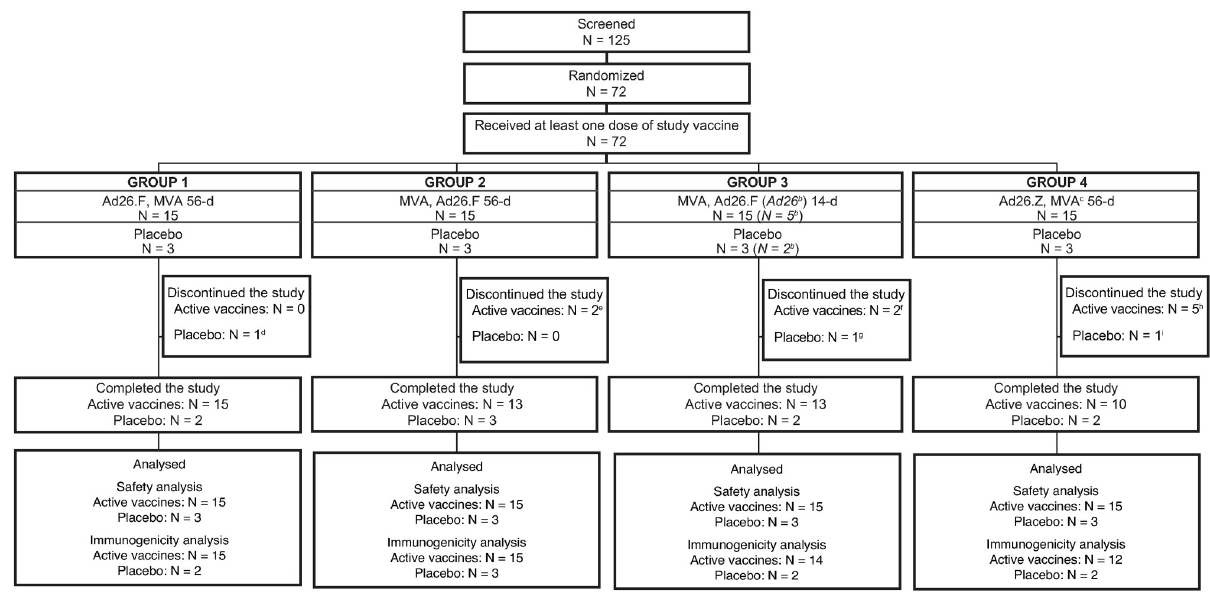
Fig 1. Participant disposition a . Ad26.F = Ad26.Filo; Ad26.Z = Ad26.ZEBOV; Inf U = infectious units; MVA = MVA-BN-Filo; N = number of participants. a A total of four participants had a major protocol deviation. In Group 1, one participant received disallowed concomitant therapy (bleomycin and cisplatin) during the post-dose 2 follow-up period. In Group 2, one participant did not have a Day 8 visit. In Group 4, one participant did not have a Day 8 visit, and another participant received a disallowed concomitant therapy (prednisone) and, as a result, discontinued the study prior to receiving the second vaccination. Participants were considered lost to follow-up after multiple unsuccessful contact attempts. b Only a subset of Group 3 participants received a booster vaccination. c MVA-BN-Filo at a dose of 1x10 8 Inf U. d Participant was unable to attend visits due to a family emergency. This participant had only received dose 1 vaccination. e Participants were lost to follow-up. One of two participants had only received dose 1 vaccination. f One participant was lost to follow-up and one participant suddenly relocated. One of two participants had only received dose 1 vaccination. g Withdrawal by the participant (no longer interested in participating). This participant had only received dose 1 vaccination. h Withdrawal by the participant (one participant was out of town and no longer interested in participating, one participant did not want to receive the second vaccination, one participant relocated, and one participant moved out of state) and one participant was lost to follow-up. One additional participant was unable to receive the second vaccination due to taking disallowed medication (prednisone) to treat an adverse event of left hip pain; this participant did not discontinue study participation. Three of five participants had only received dose 1 vaccination. i Participant was lost to follow-up. This participant had only received dose 1 vaccination.